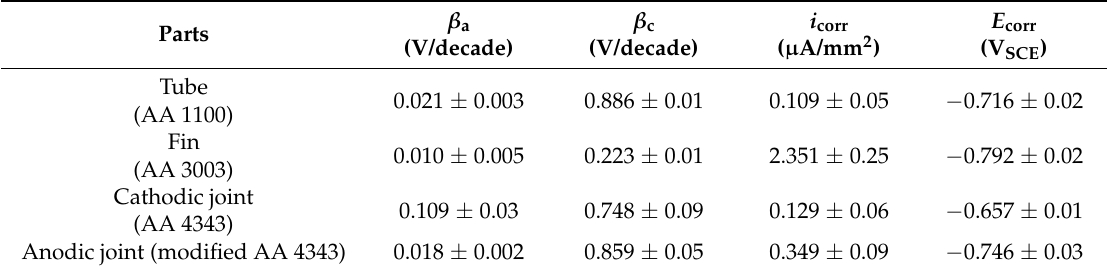
Figure 4. Polarization curves of each part of the Al fin-tube heat exchanger. 166 Table 2. Potentiodynamic polarization test results of different parts of the Al fin-tube heat exchanger (Al 1100, Al 3003, Al 4343, and modified Al 4343). 168